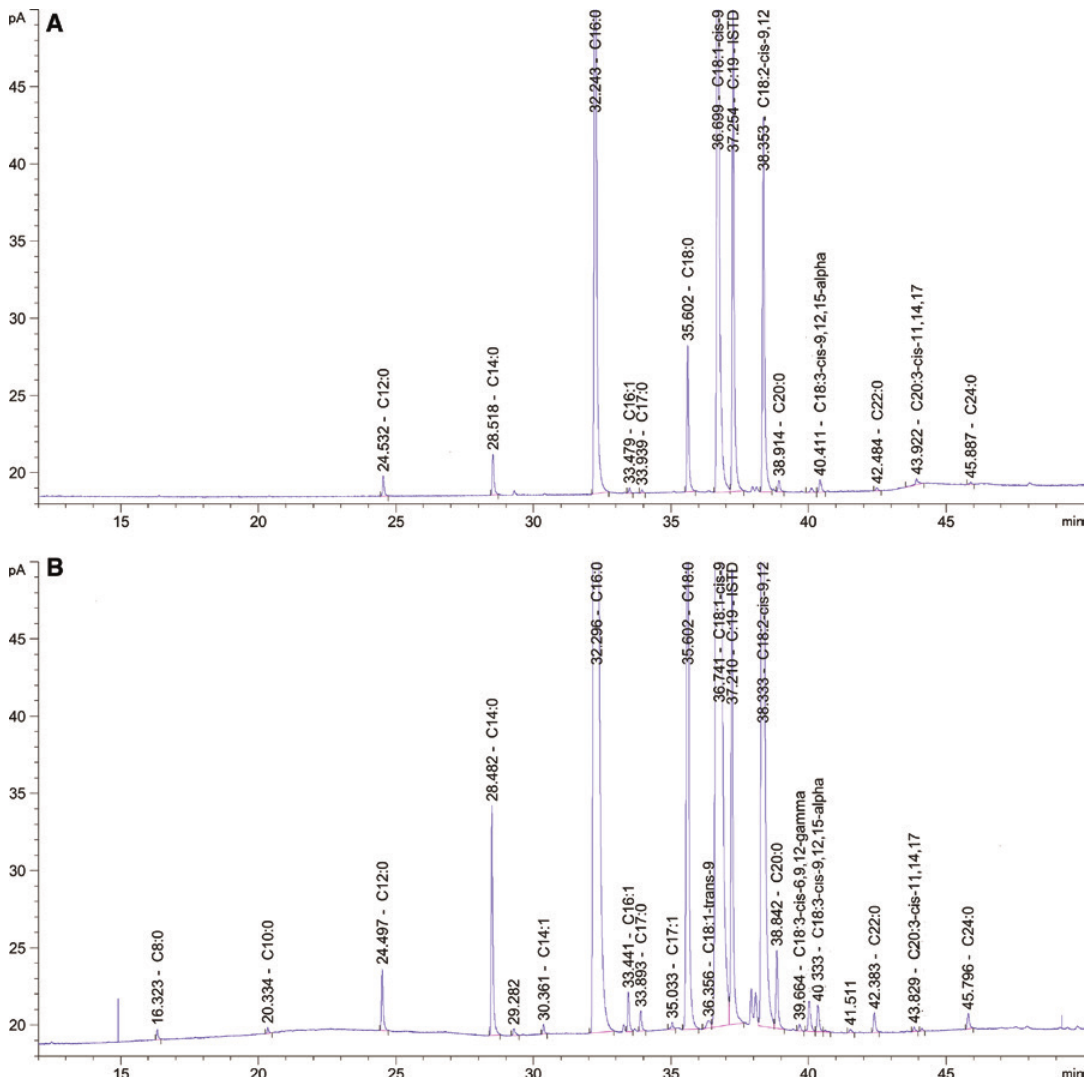
Figure 2: The chromatograms obtained from the reaction mixture (A) for CH, T = 42 ° C, t = 5 min (B) for MWHCC, T = 42 ° C, t = 3